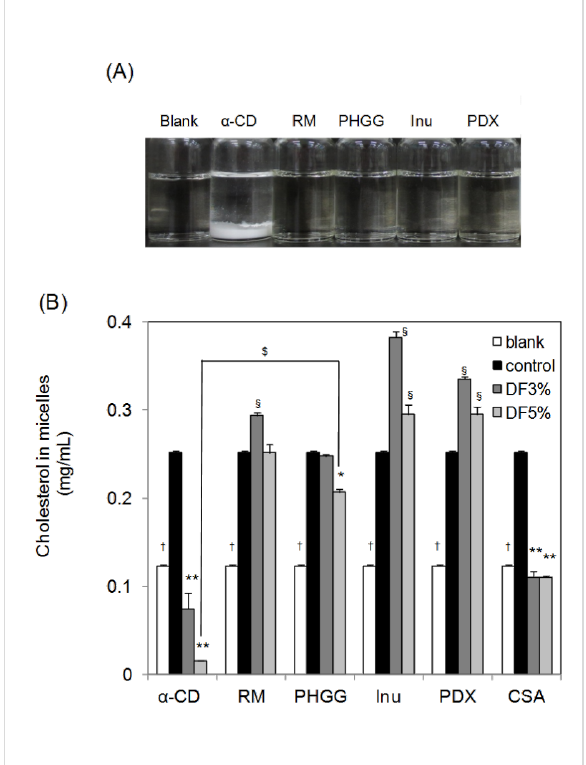
Figure 7: Effect of several dietary fibers on the micellar cholesterol solubility in FeSSIF. Various amounts of α -CD, Resistant Maltodextrin (RM), Partially Hydrolyzed Guar Gum (PHGG), Inulin (Inu), Polydex- trose (PDX) or Cholestyramine (CSA) were added to 15 mL of FeSSIF at 37 °C. The experimental conditions were the same as those described in the legend to Figure 6. (A) Image of FeSSIF with each dietary fiber at a concentration of 5%. (B) Cholesterol concentration in micelles after shaking for 120 minutes with additional cholesterol (control) or with no added α -CD or cholesterol (blank). Means and standard errors are indicated ( n = 3). ** ,†,§ P < 0.01, significantly different from control. $ P < 0.01, significantly different between α -CD 5% and PHGG